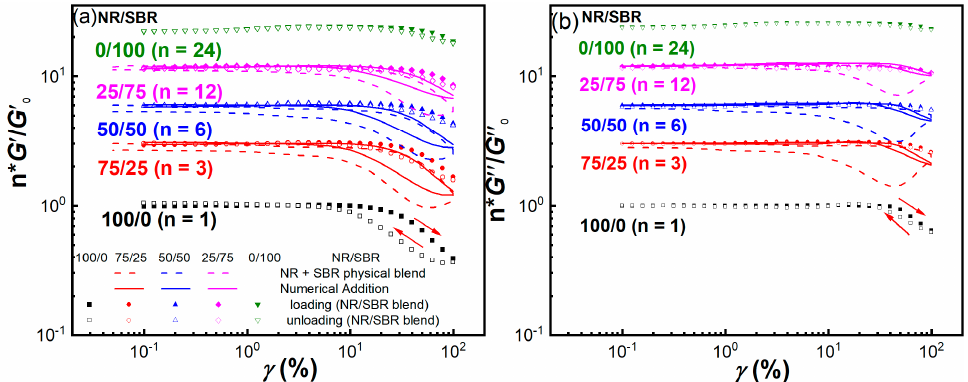
Figure 7. ( a ) G ′ / G ′ 0 and ( b ) G ′′ / G ′′ 0 as a function of γ for NR/SBR blends (symbols) and NR + SBR physical blends (dashed lines) during a loading–unloading cycle at 100 °C and 1 rad/s. The solid lines are predicted by numerical addition results of neat NR and SBR. Here, N is also the vertically shifting factor for the normalized moduli. The arrows indicate the loading and unloading processes.